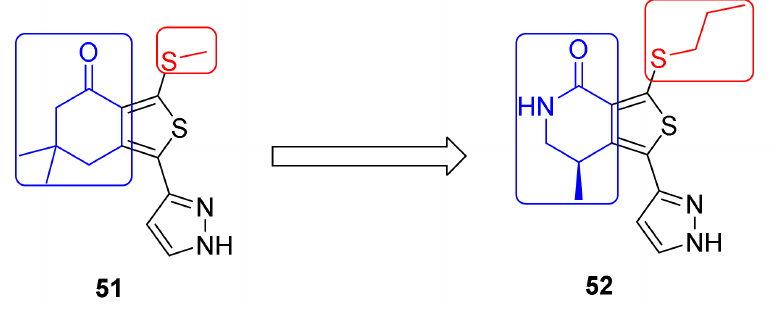
Figure 58. Development of compound 52 from 51 through introduction of amide lactam ring instead of cyclic ketone and extension of methylthio to